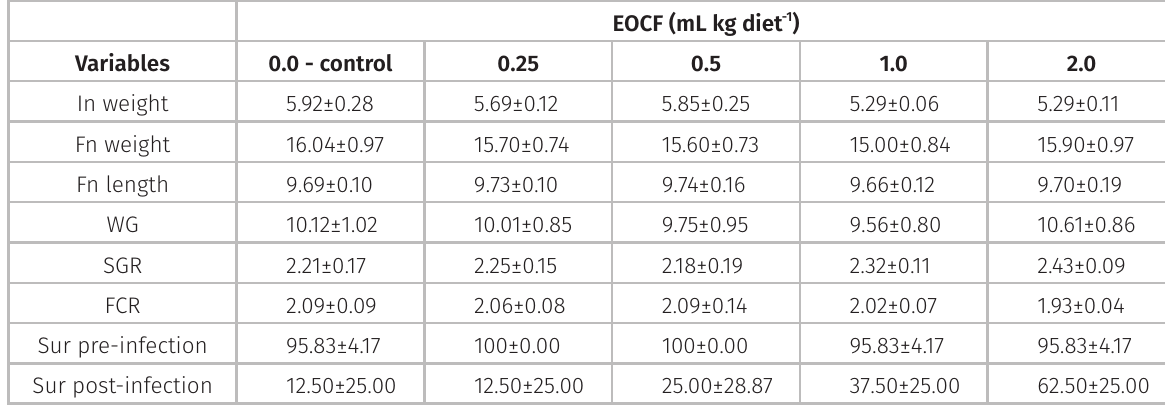
Table II. Growth performance and survival of Nile tilapia fed with diets containing different concentrations of the essential oil of Cymbopongon flexuosus